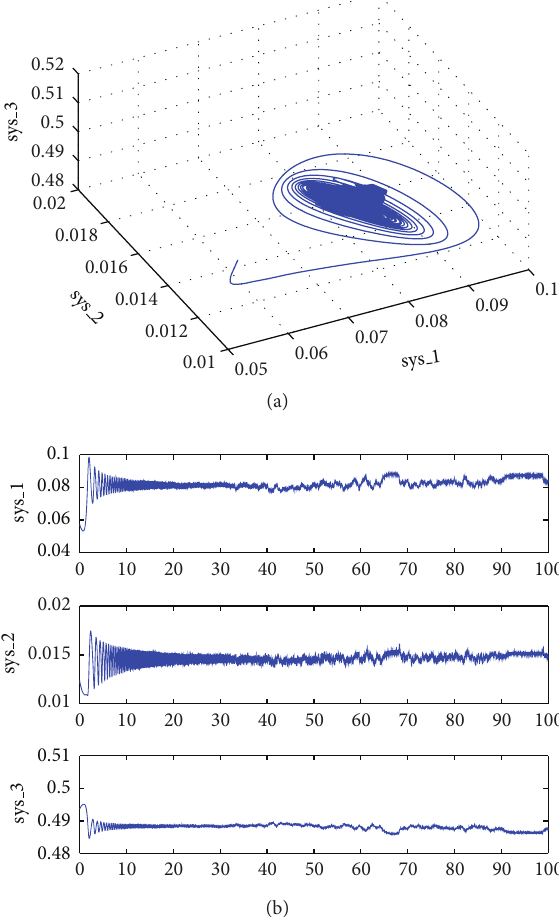
Figure 8: The attractor and the time series of the deterministic Lorentz-R¨ossler